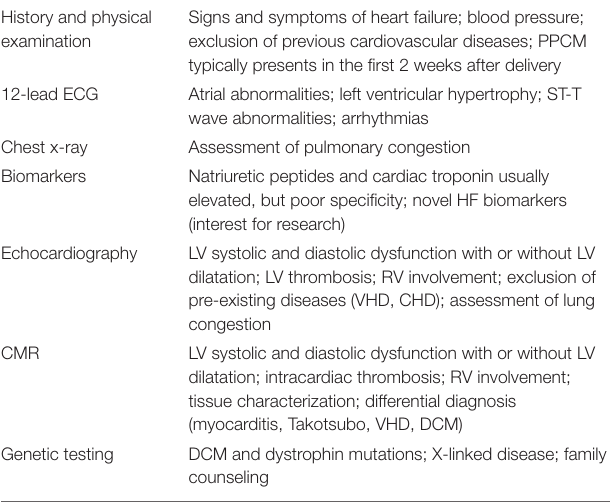
TABLE 1 | Clinical workup of patients with suspected peripartum